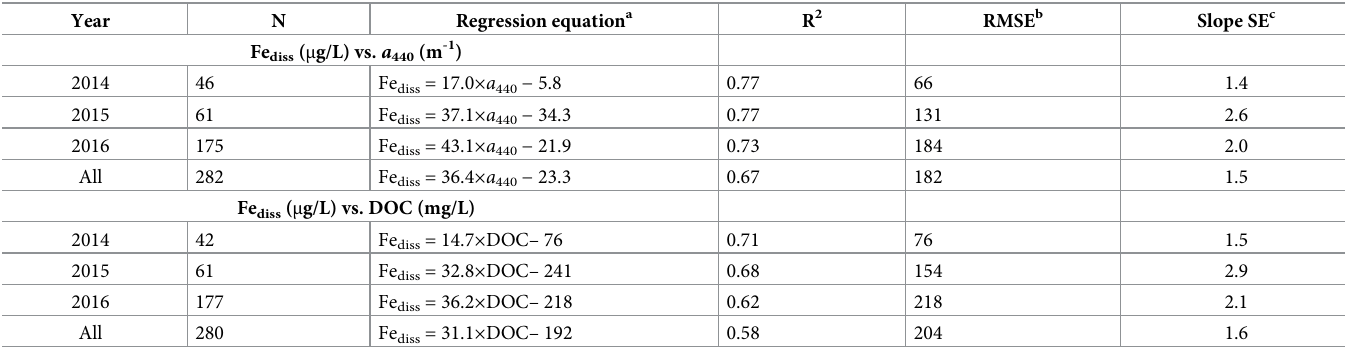
Table 2. Dissolved Fe-CDOM and Fe-DOC relationships.